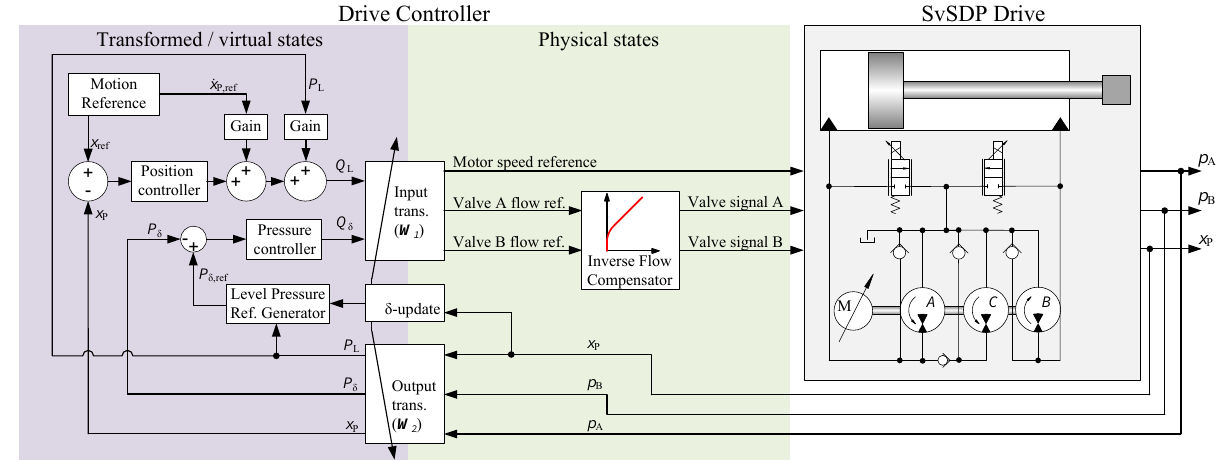
Figure 4: Schematic of the complete drive control system. Schmidt et al.